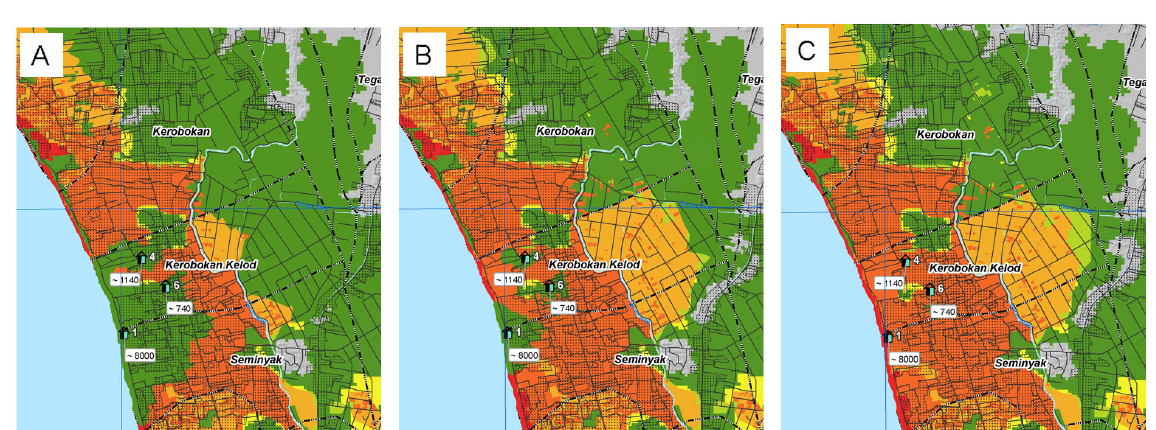
Fig. 6. Variations of risk information at different input parameters. (A) presumes an available evacuation time of 20min and considers evacuation buildings and areas (vertical and horizontal evacuation); (B) presumes 10min of available evacuation time and also considers both vertical and horizontal evacuation possibilities; (C) presumes 20min but does not consider people’s response